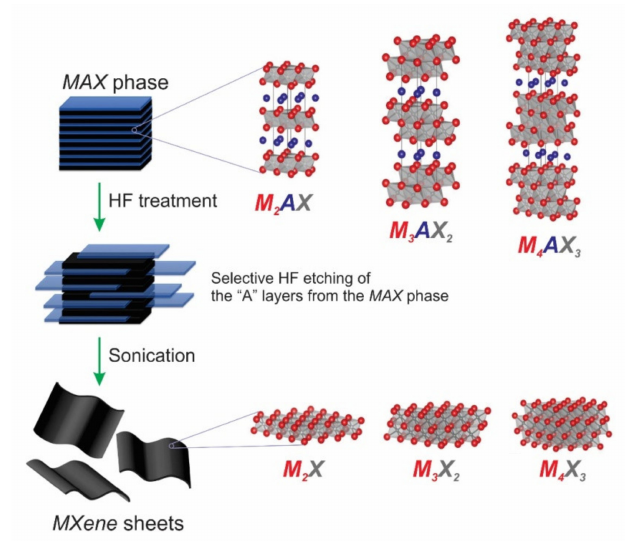
Figure 1. The schematic diagram is representing the process of synthesizing MXenes from MAX phases. Reproduced with permission from [31]. Copyright Wiley-VCH, 2014 and [32] Copyright American Chemical Society,